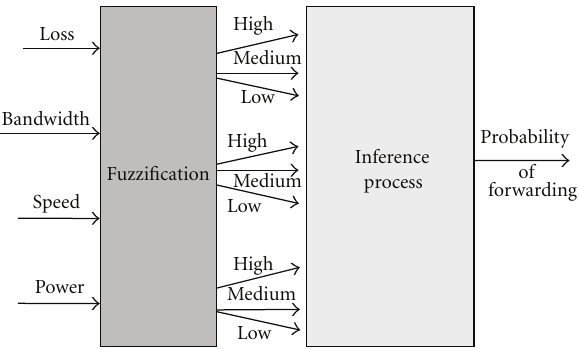
Figure 1: Computing probability of caching or